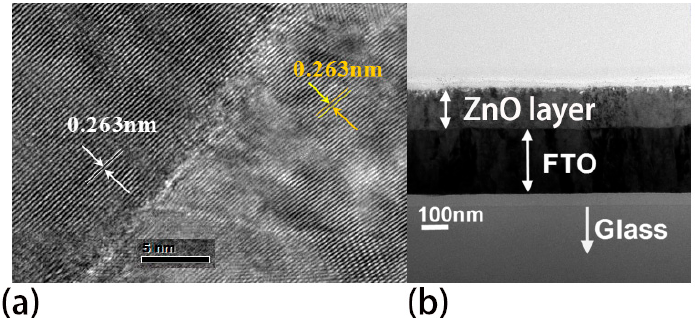
Figure 1. Transmission electron microscope (TEM) images of the zinc oxide (ZnO)/indium tin oxide (ITO)/glass structure ( a ) plan-view and ( b ) cross-sectional image.